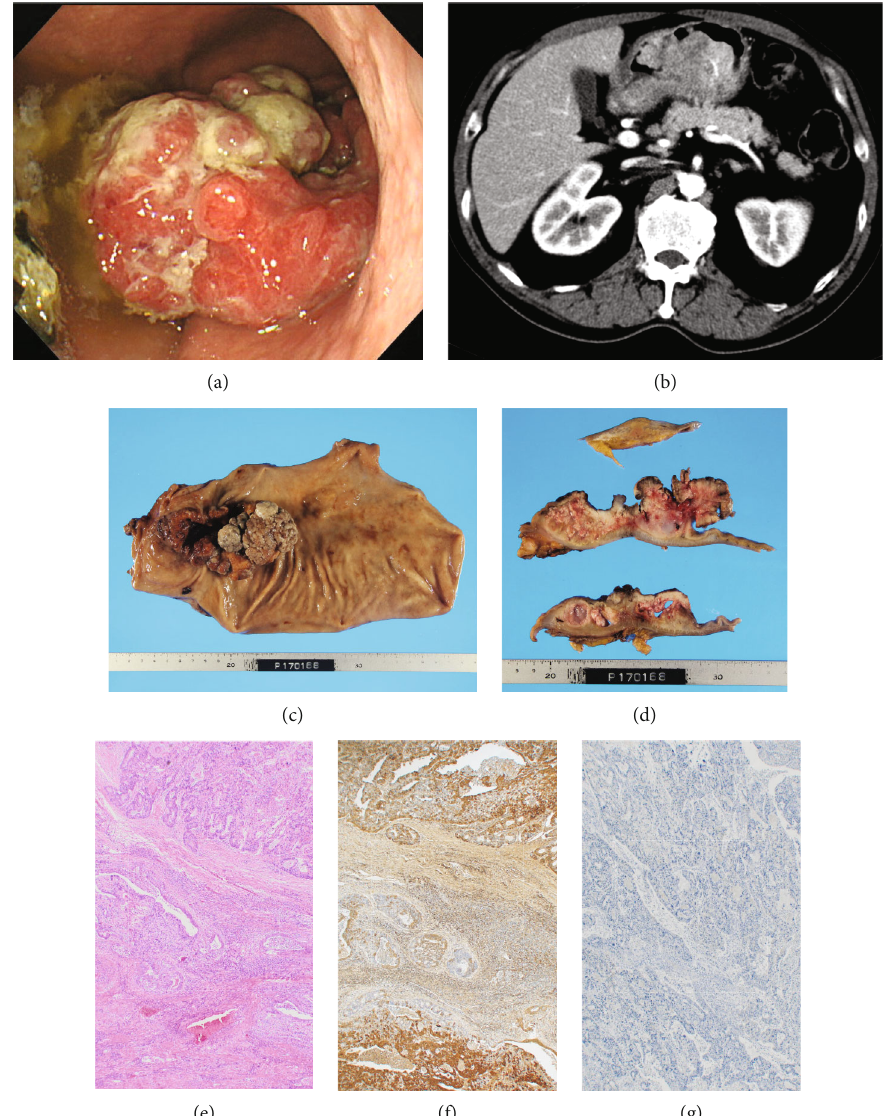
Figure 1: Preoperative fi ndings and histopathological analysis of the resected specimen. Upper endoscopy revealing a semicircular type 2 tumor on the greater curvature of the gastric corpus that extends to the pylorus (a). Contrast-enhanced computed tomography depicting bulky thickening of the distal stomach wall, without invasion to the pancreas or ascites, lymph node or remote metastases, or liver tumors (hepatocellular carcinoma or metastatic liver tumor) (b). Open total gastrectomy, lymphadenectomy, and Roux-en-Y reconstruction were performed (c). The histopathological diagnosis was gastric cancer (pT2, N2, M0, stage IIB (Union for International Cancer Control TNM Classi fi cation of Malignant Tumors, 8th edition)) (d, e). Immunostaining of the primary tumor was positive for alpha-fetoprotein and negative for human epidermal growth factor receptor 2 (f, g,